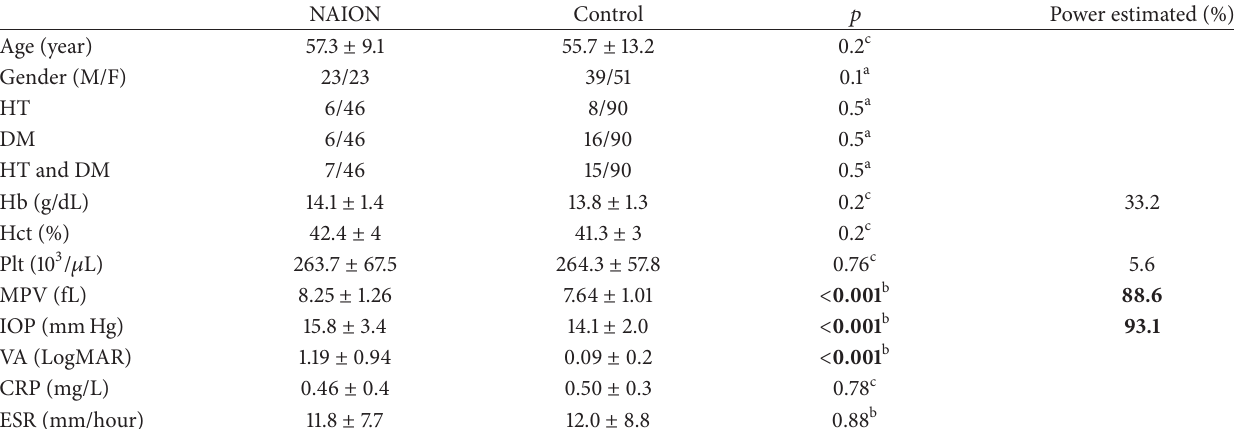
Table 1: The demographic and clinical features of the NAION and control groups. NAION Control 𝑝 Power estimated